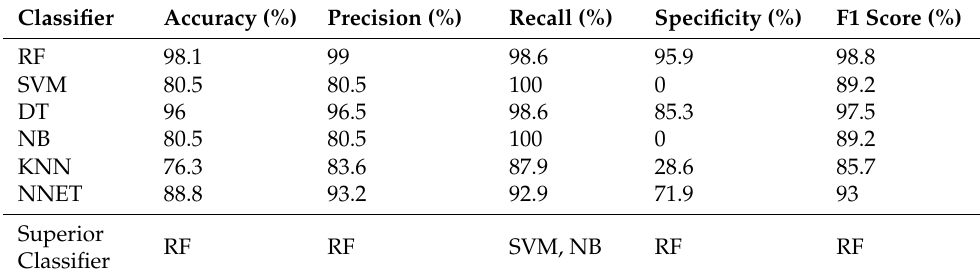
Table 1. Performance comparison of single-classifier approach on the median imputed dataset.